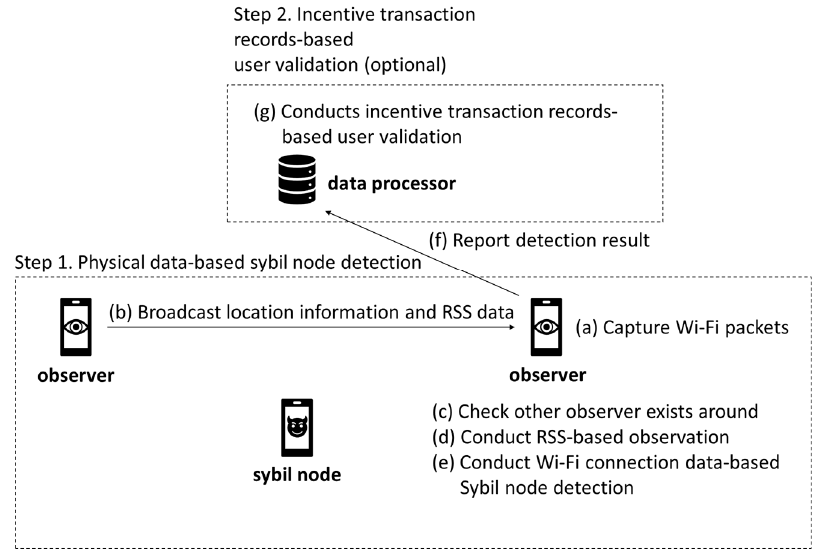
Figure 4. Sybil attack detection flow: ( a ) Observer Wi-Fi packets monitoring; ( b ) Observer information broadcasting; ( c ) Observer existence checking; ( d ) RSS-based observation; ( e ) Wi-Fi connection data-based detection; ( f ) Detection result reporting; ( g ) Incentive transaction records-based user validation.